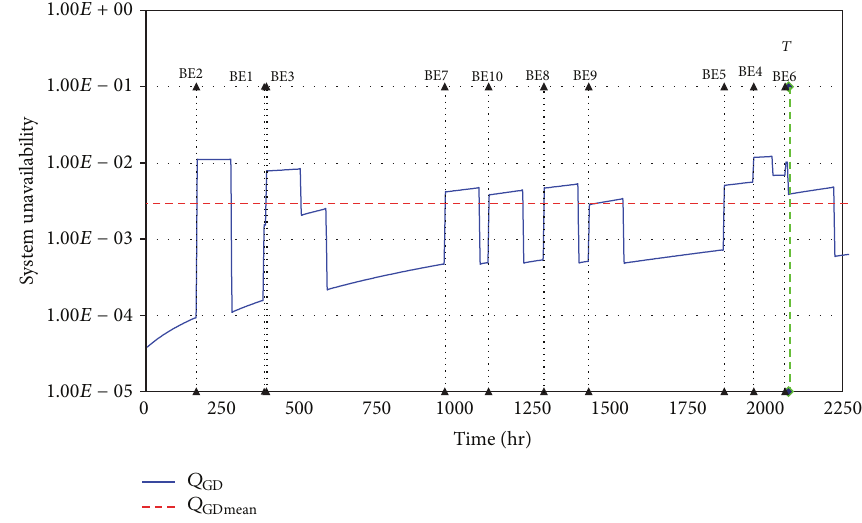
Figure 6: System unavailability of the AFW system over time for case scenario 2 with consideration of the Δ SET.